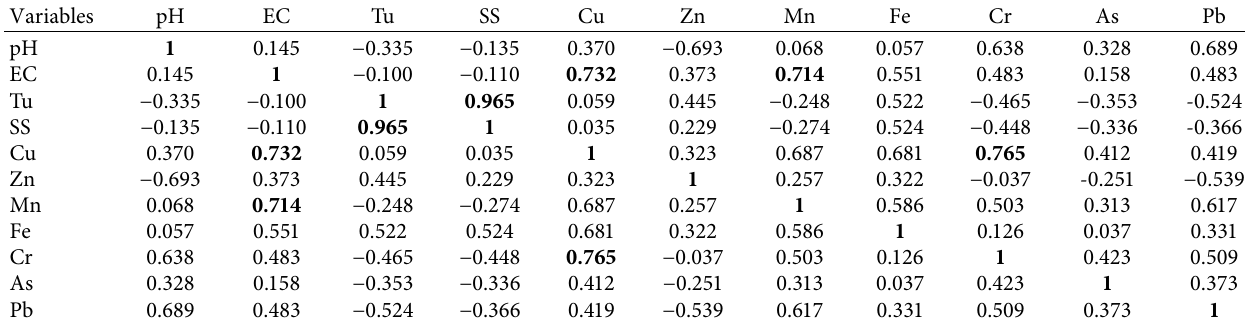
Table 4: Correlation matrix between parameters determined in water samples.